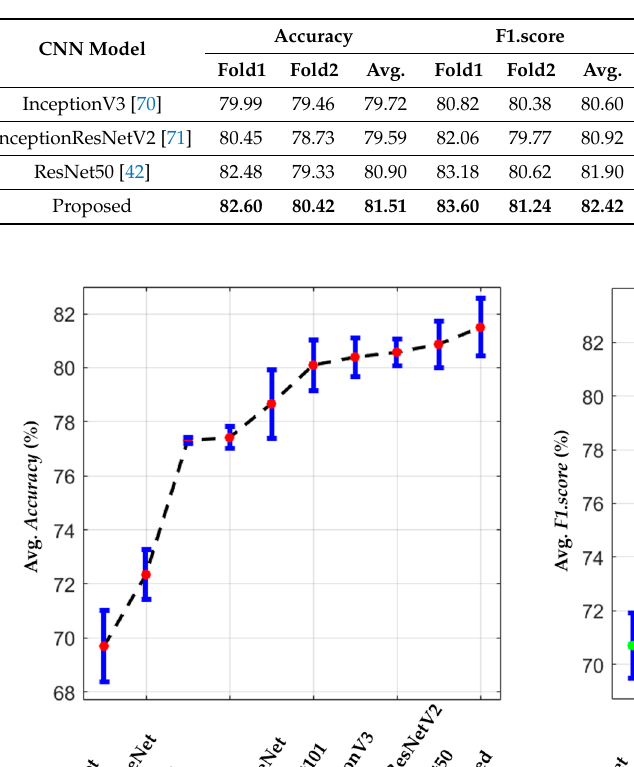
Table 6. Classification performance of proposed and di ff erent baseline CNN models in the case of transfer learning (unit: %).